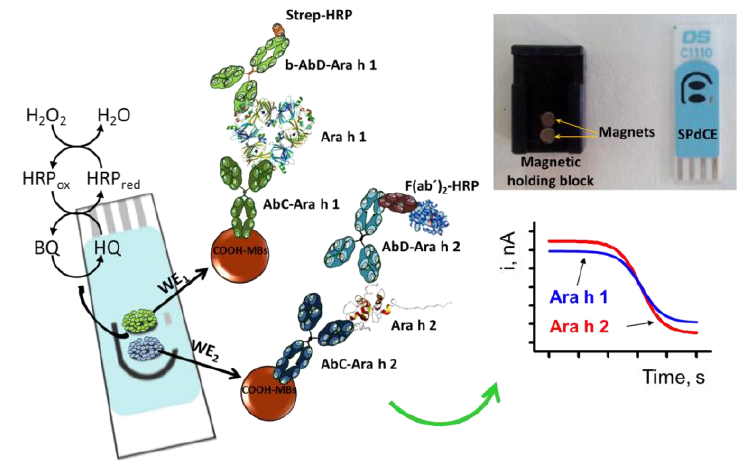
Figure 1. Schematic display of the fundamentals involved in the dual determination of Ara h 1 and Ara h 2 using screen-printed dual carbon electrodes (SPdCEs) as well as in the reactions implied in the amperometric responses. A real picture of the SPdCE and the homemade magnetic holding block is also shown.